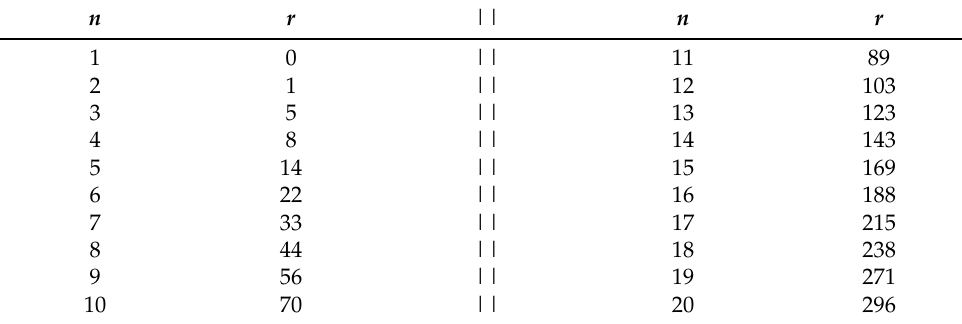
Table 1. Degree Elevation r for Degree n